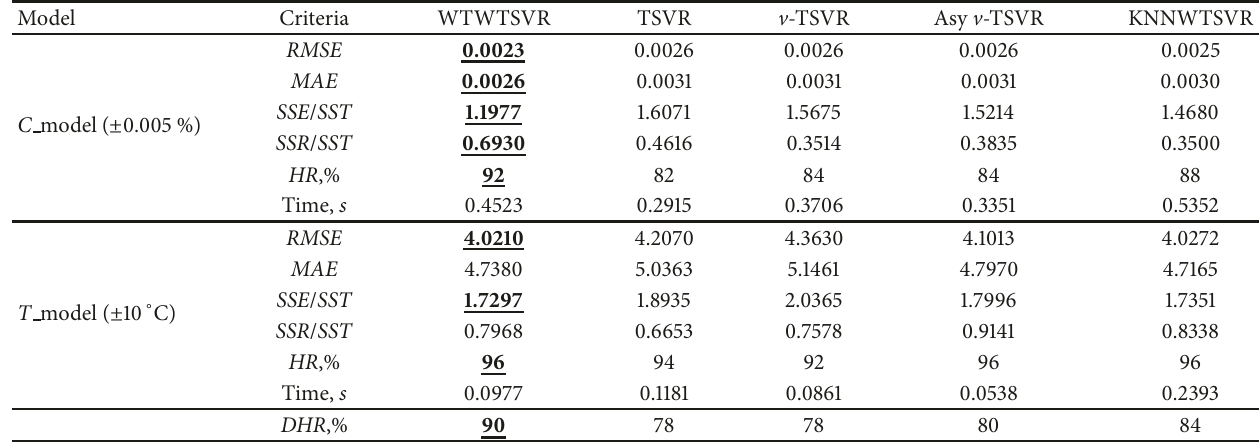
Table 7: Performance comparisons of C/T prediction models with four